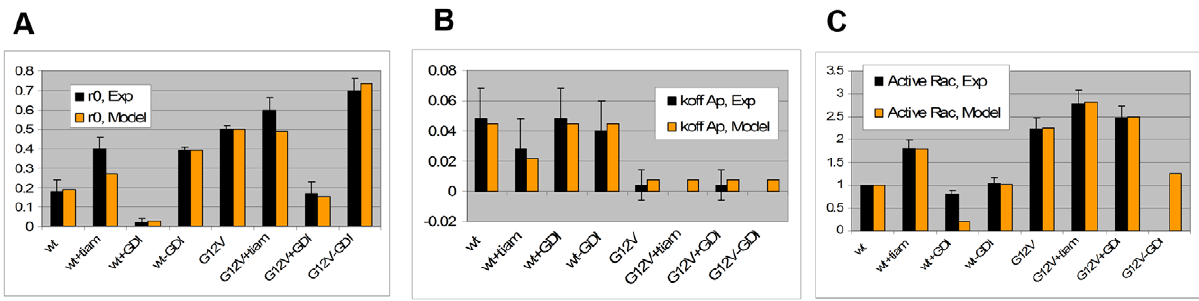
Figure 3. Comparison between experimental data ‘‘Exp’’, black bars [ 15 ] and ‘‘Model’’. A. Percentage of Rac at the membrane r0. B. Apparent membrane dissociation rate koff Ap (s 2 1 ). C. Total active GFP-Rac in the cell. The nomenclature for each of the eight experimental conditions is defined in Section Detailed model. Experimental measurements of koff Ap were not performed for 2 conditions and of Active Rac for one condition; the model predictions for those conditions are provided.